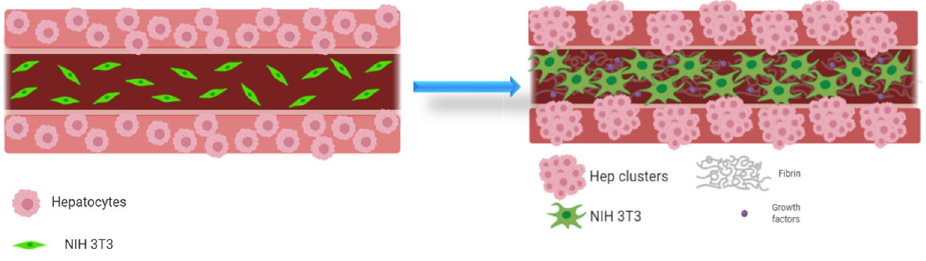
Figure 6. Graphical representation of the hepatocyte-fibroblast co-culture concept, showing hepatocytes encapsulated in the shell are coaxially printed with NIH 3T3 fibroblasts in the core, both co-printed as single cells in their respective bioink (left). An influence of the core composition (with or without fibroblasts and matrix components) on hepatocyte phenotype is hypothesized as they might grow into clusters within their shell compartment and fibroblasts spread to form networks over the cultivation period (right). Images created using Biorender.com